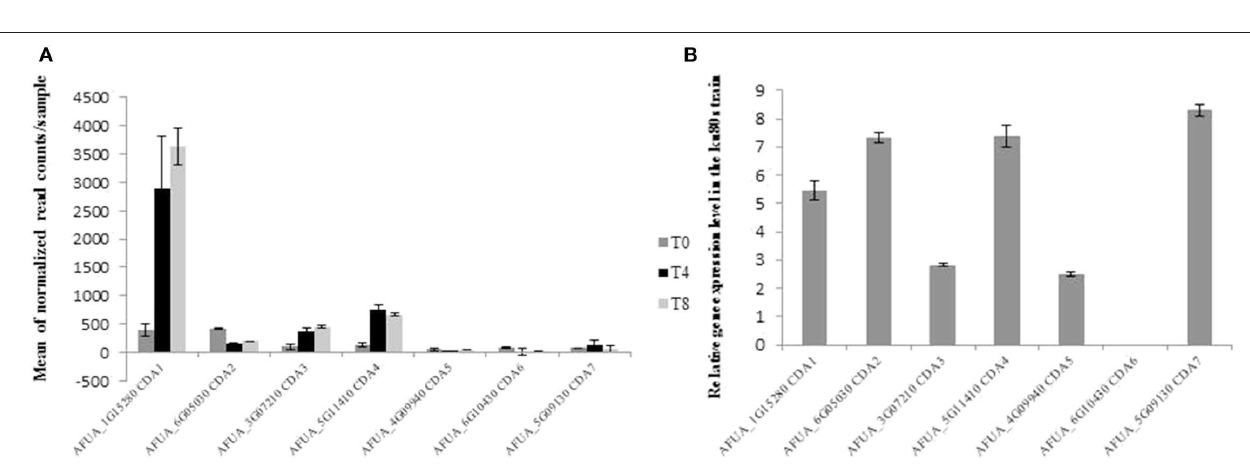
FIGURE 4 | CDA gene expression level in A. fumigatus (A) Gene expression profile of the KU80 CDA family genes in dormant (T 0h), swollen (T 4h), and germinated conidia (T 8h) in Glucose 3%/YE 1% medium. The data are extracted from RNAseq analysis data ( Mouyna et al., 2016). The errors bars represent standard deviation from the mean values of three different experiments. The data have been normalized/size of the gene (B) Relative Gene expression level of the CDA genes in the mycelium during conidiation of the parental strain (WT). The expression ratios were relative to TEF1 gene. Values are taken from the RNA-seq data analysis of Valsecchi et al. (2017). For this RNA-sequencing experiment, the fungus was grown for seven days on malt agar at 37 ◦ C at room temperature. The errors bars represent standard deviation from the mean values of three different